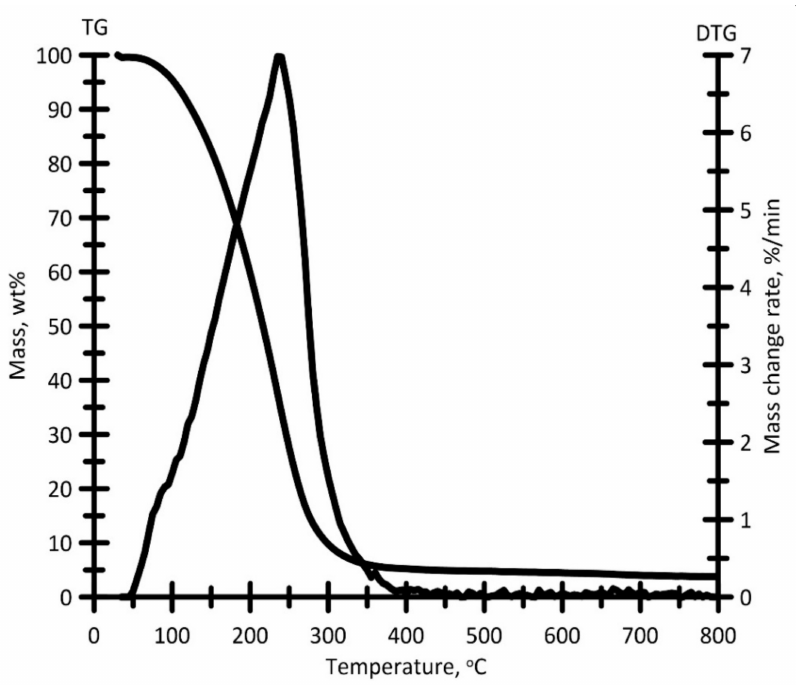
Figure 9. TG and DTG curves for evaporation and thermal decomposition of liquid hydrocarbon samples. Medium—argon 150 ml/min, heating rate—10 ◦ C/min, sample weight ≈ 15